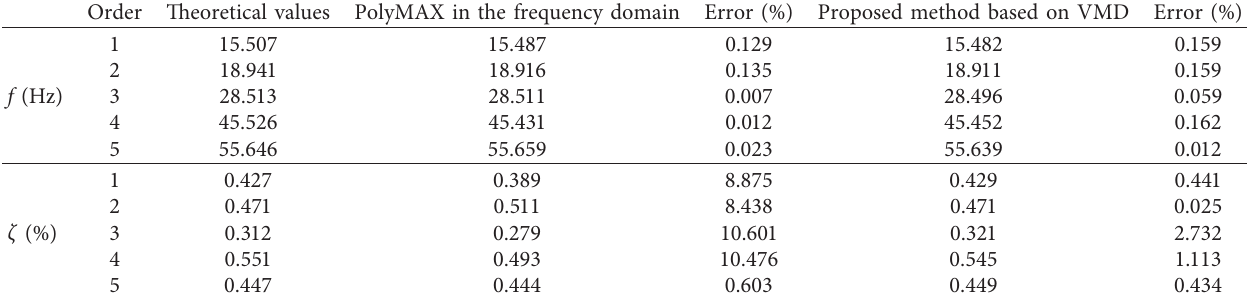
Table 3: The identified modal